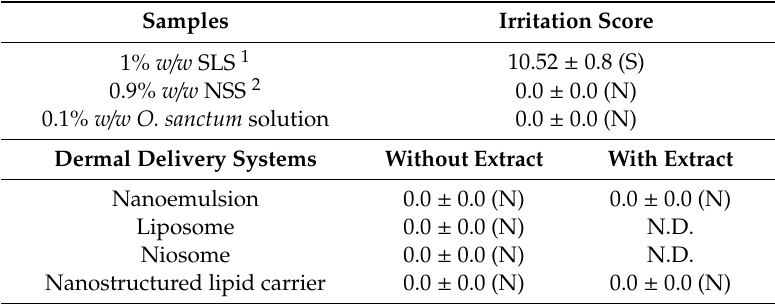
Table 4. Classification of dermal delivery systems with and without O. sanctum ethanolic extract according to the score of severity.